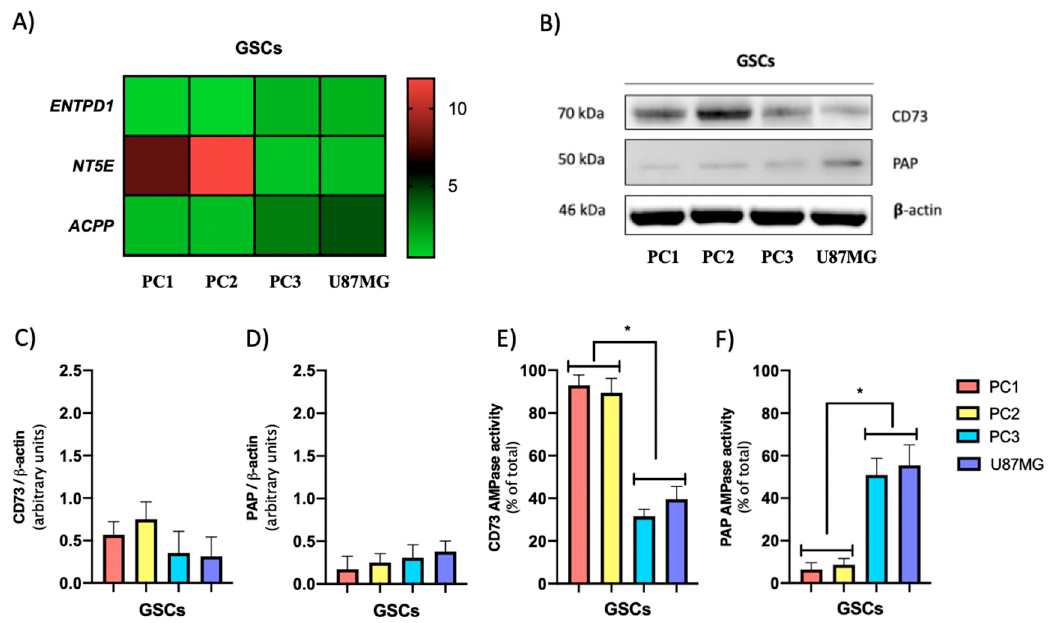
Figure 5. Expression and activity of AMP metabolizing enzymes in proneural and mesenchymal GSCs. ( A ) Relative transcript levels from ENTPD1, NT5E, and ACPP genes in proneural (PC1 and PC2) and mesenchymal (PC3 and U87MG) GSCs. Values were normalized to ACTB mRNA